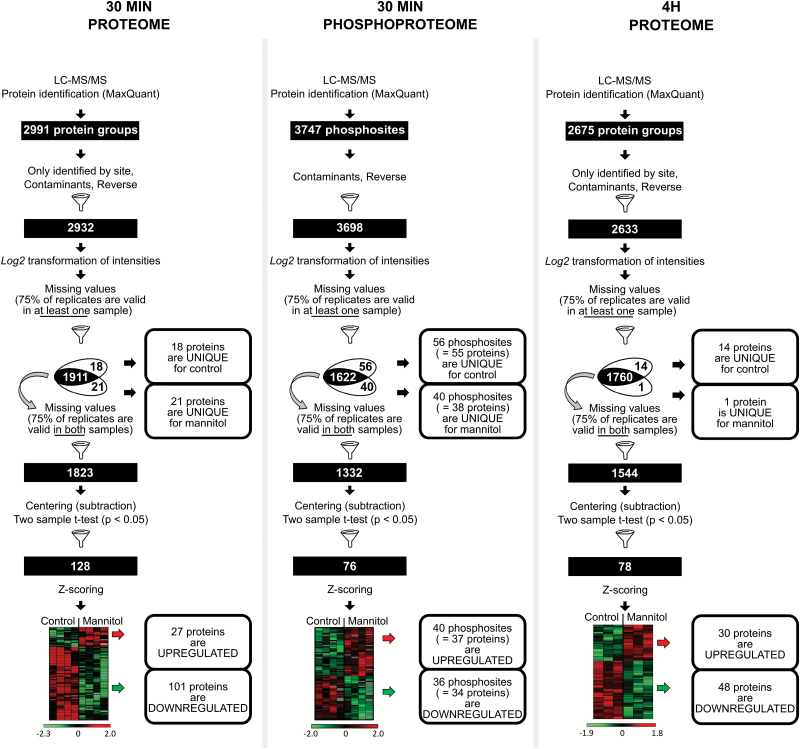
Mannitol-triggered changes in protein or phosphosite abundance upon 30 min and 4 h exposure. This workflow illustrates the steps to obtain a reliable set of proteins or phosphopeptides following LC-MS/MS. Venn diagrams indicate steps where unique proteins/phosphosites (with corresponding numbers) were filtered out from the statistical analysis. Heatmaps represent a hierarchical clustering of statistically significant proteins and phosphosites based on Pearson correlation. Centred Z-scored log2-transformed intensity values on heatmaps are colour-coded according to the colour gradient scales provided.